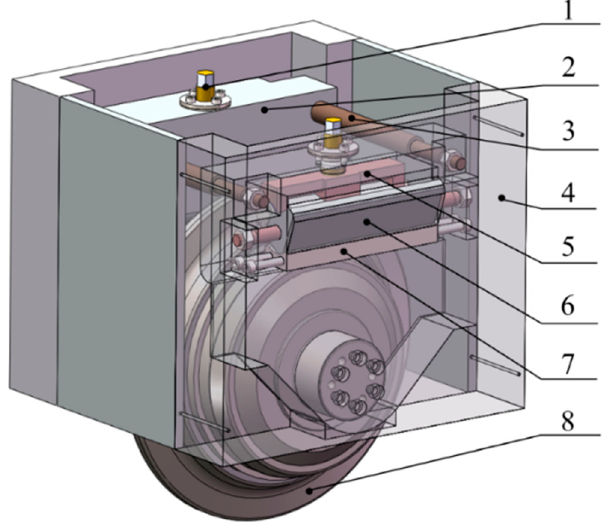
Figure 1. New integrated TBM disc cutter. 1—Thread fastening system, 2—Cutter holder, 3—Lifting rod, 4—Cutter box, 5—Shift fork, 6—Clamping block, 7—Cushion block, 8—Disc cutter.